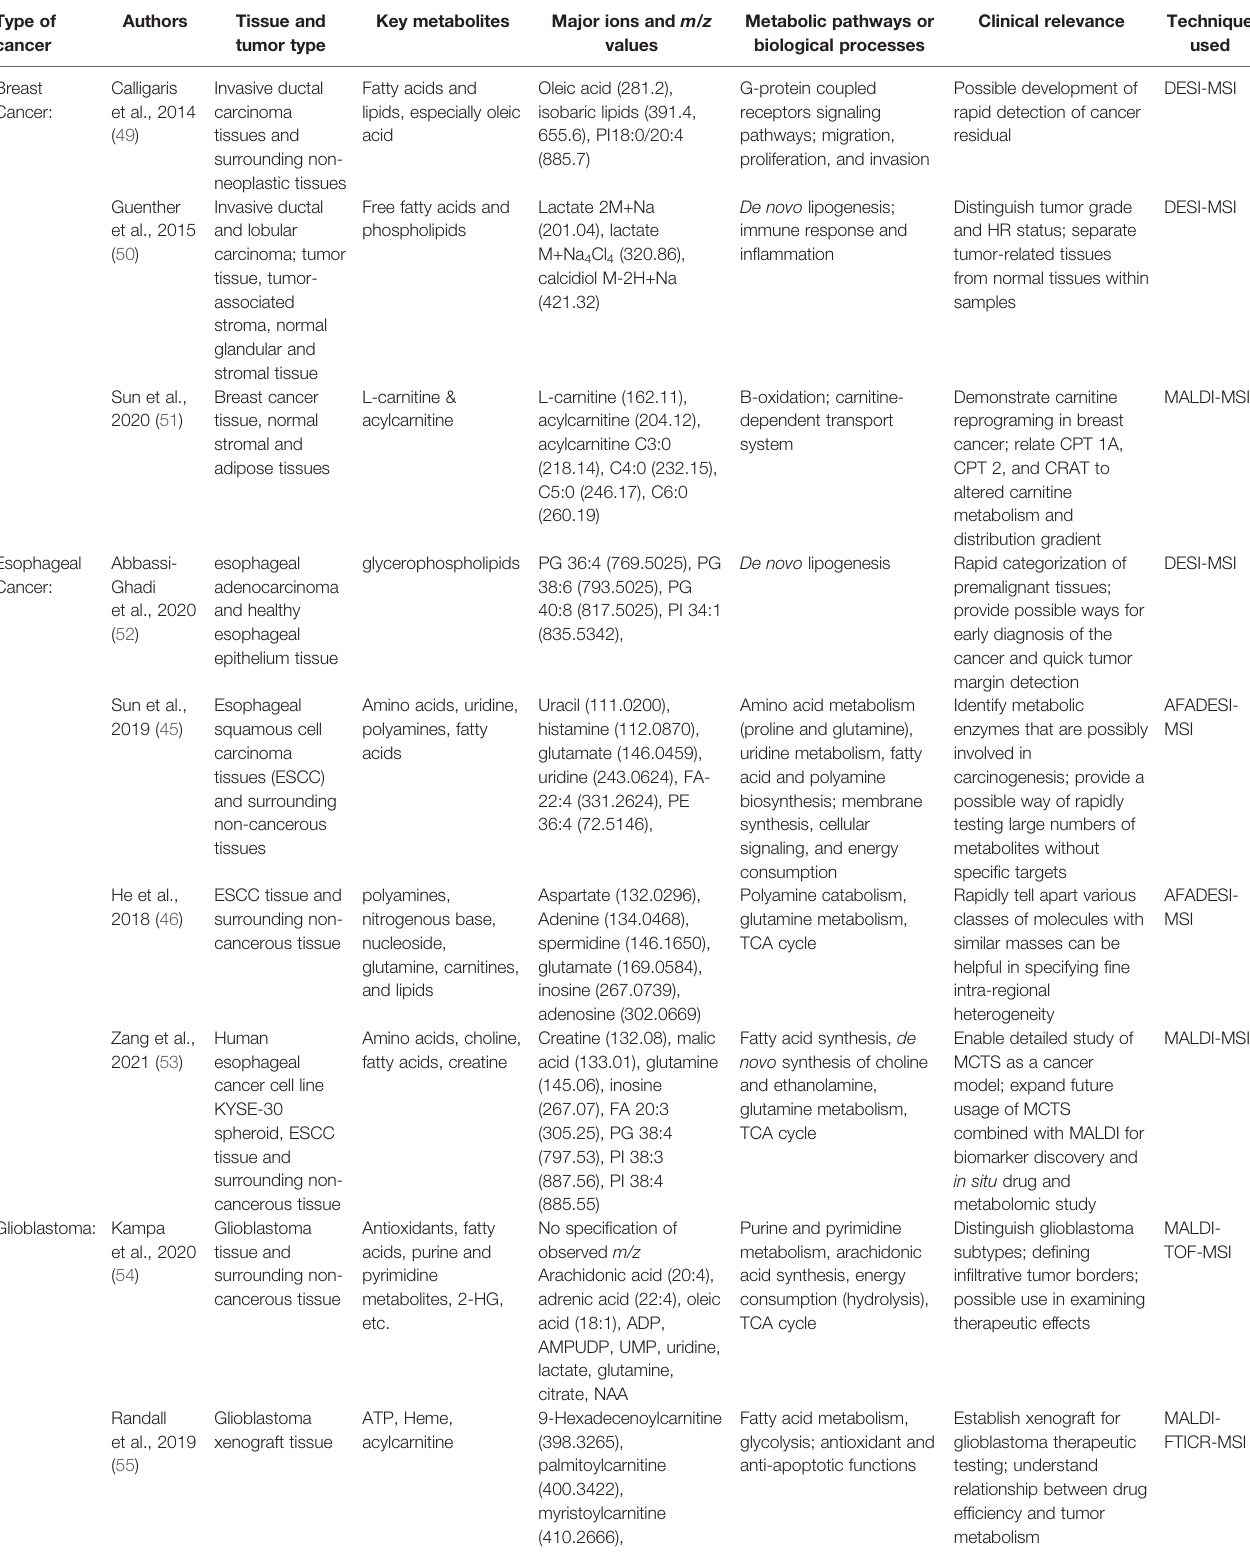
TABLE 2 | Summary of Key Papers on Spatial Metabolomics in Cancer